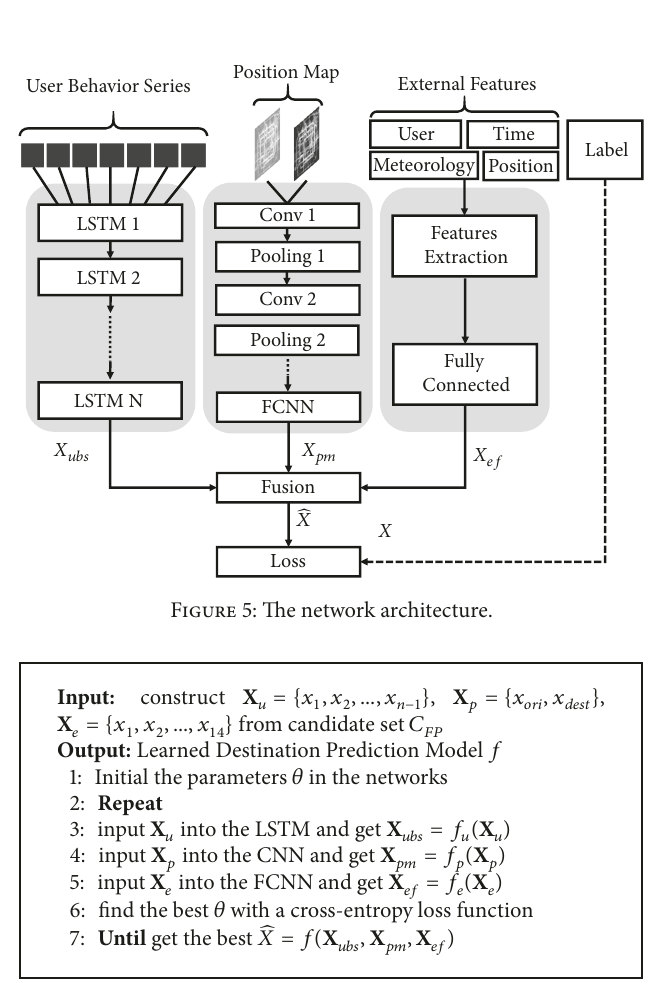
Algorithm 2: Destination prediction training